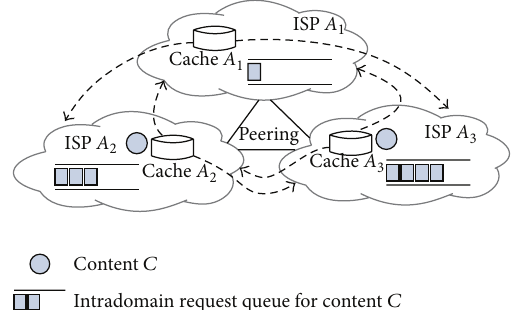
Figure 1: Interdependent ISPs 𝐴 1 , 𝐴 2 , and 𝐴 3 build peering relationships between each other through cache-to-cache content sharing. Request queues for content 𝐶 within the three ISPs indicate intradomain popularity of content 𝐶 . Both 𝐴 2 and 𝐴 3 cache the content 𝐶 . 𝐴 1 does not cache 𝐶 but can receive it from 𝐴 2 or 𝐴 3